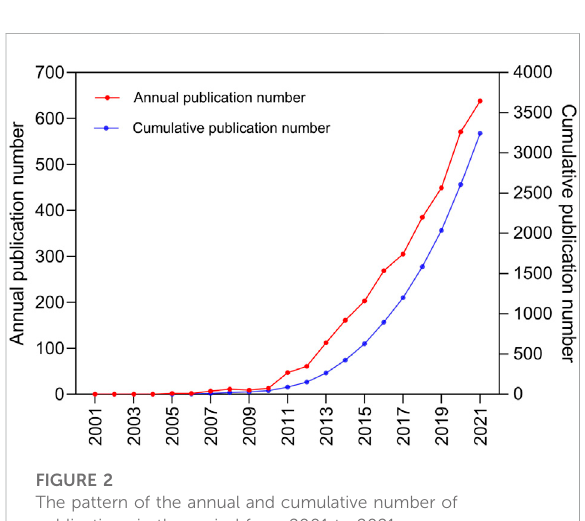
FIGURE 2 The pattern of the annual and cumulative number of publications in the period from 2001 to